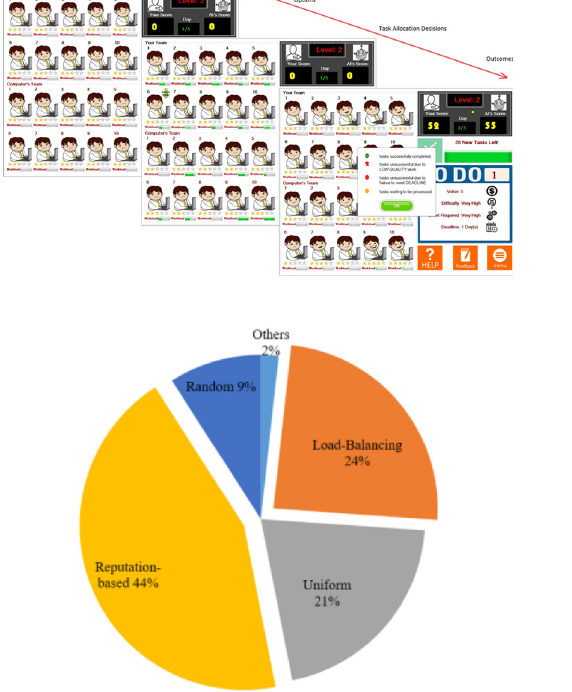
Figure 5. The distribution